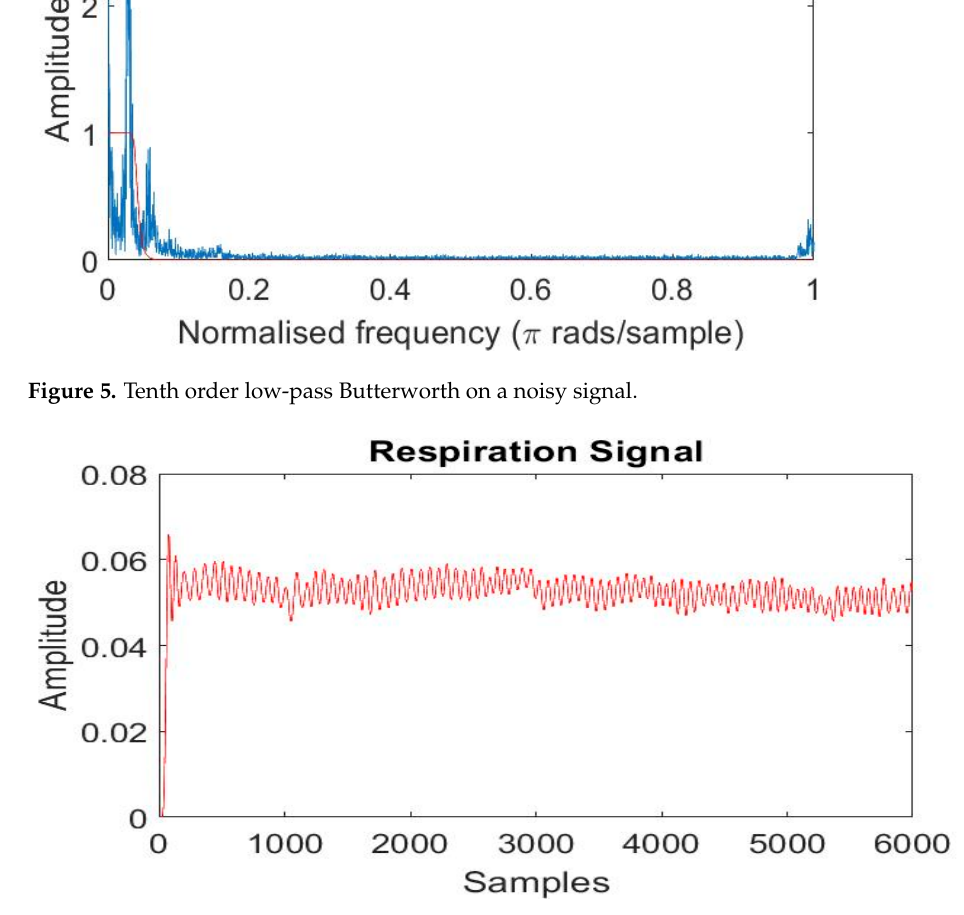
Figure 6. Respiration signal.